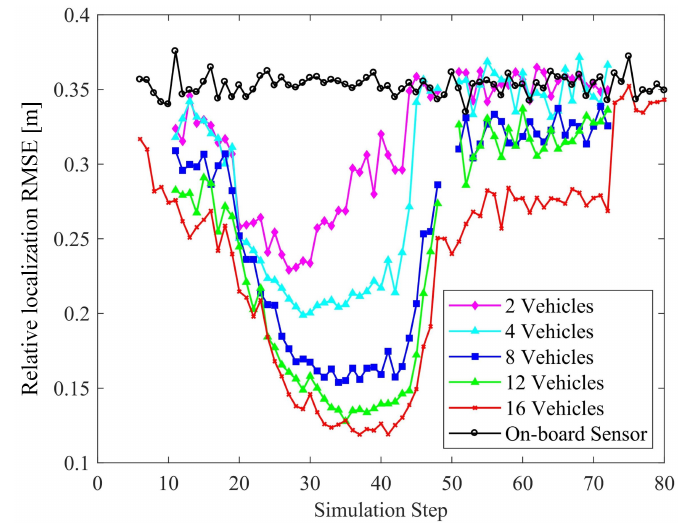
Figure 10. Effect of the number of connected vehicles on localization accuracy.